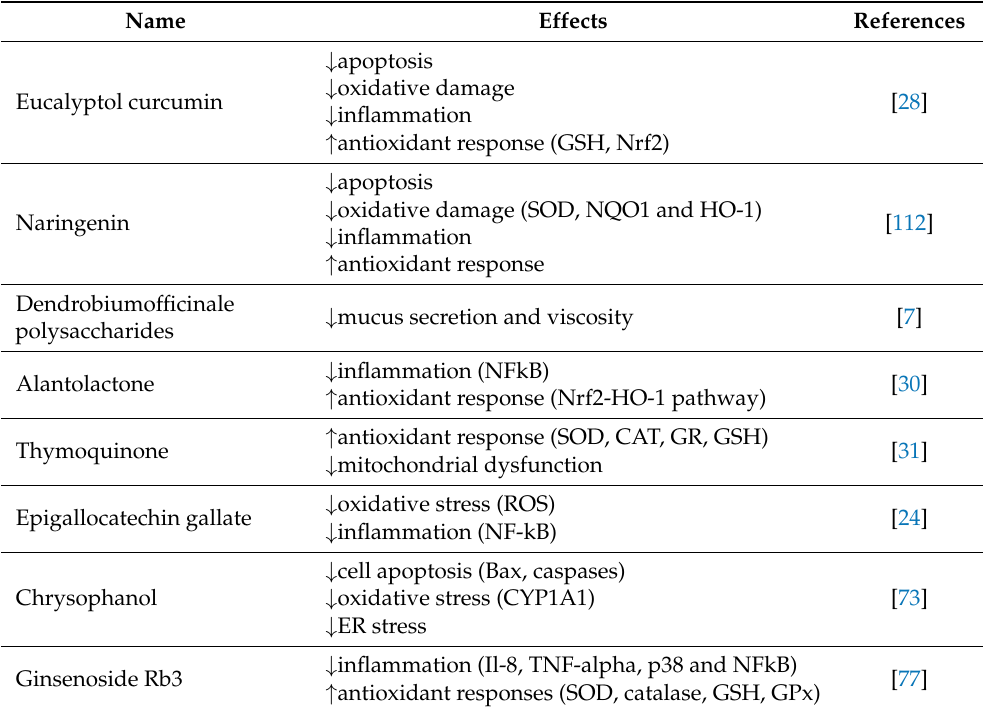
Table 1. Natural antioxidant compounds.